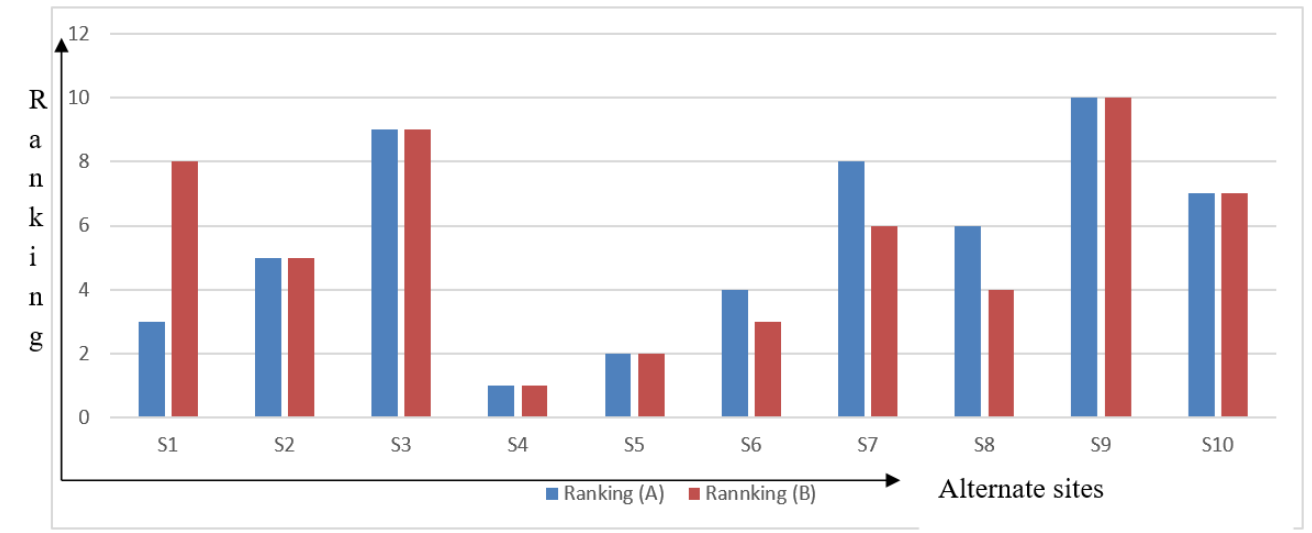
Figure 12. Sensitivity analysis ranking obtained under fuzzy AHP-COPRAS.